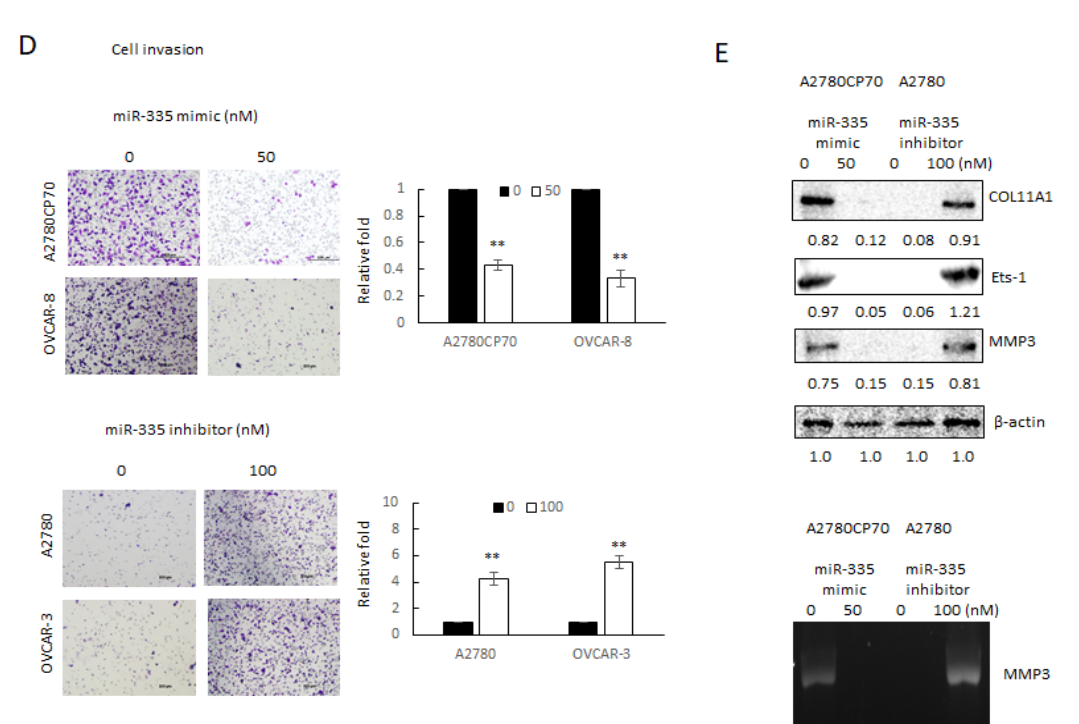
Figure 2. Invasive phenotypes of epithelial ovarian carcinoma cells are regulated by miR-335. ( A ) Messenger RNA (mRNA) expression levels of collagen type XI alpha 1 (COL11A1) and miR-335 in A2780CP70 and OVCAR-8 cells transfected with miR-335 mimic, as well as A2780 and OVCAR-3 cells transfected with miR-335 inhibitor, were evaluated by real-time reverse transcription-polymerase chain reaction (RT-PCR). All experiments were performed in triplicate. ( B ) The cell growth of A2780CP70 and OVCAR-8 cells transfected with miR-335 mimic and A2780 and OVCAR-3 cells transfected with miR-335 inhibitor for 48 h. Cell viability was assessed by 4,5-dimethylthiazol-2-yl)-2,5-diphenyltetrazolium bromide assays. All experiments were performed in triplicate; ** p < 0.01, *** p < 0.001, compared with control. ( C ) pCMV6-AC- GFP-COL11A1 and miR-335/NC were co-transfected into A2780CP70 and OVCAR-8 cell lines. The experimental results of MTT displayed that the cell proliferation rate was obviously decreased after transfection with the mimic of miR-335, while the overexpression of COL11A1 turned over the apparent inhibition of cell proliferation by miR-335. NC: negative control; ** p < 0.01, *** p < 0.001. ( D ) The invasive ability of A2780CP70 and OVCAR-8 cells transfected with miR-335 mimic and A2780, as well as OVCAR-3 cells transfected with miR-335 inhibitor for 48 h. All data represent the mean ± SD of three separate experiments; ** p < 0.01, compared with control. ( E ) Upper panel: the protein expression of COL11A1, Ets-1, and MMP3 in A2780 cells transfected with miR-335 inhibitor, as well as A2780CP70 cells transfected with miR-335 mimic, were evaluated by western blot. β -Actin is used as a protein loading control. Lower panel: MMP3 activity is evaluated in A2780 cells transfected with miR-335 inhibitor, as well as A2780CP70 cells transfected with miR-335 mimic (Figure S2A). All experiments were performed in